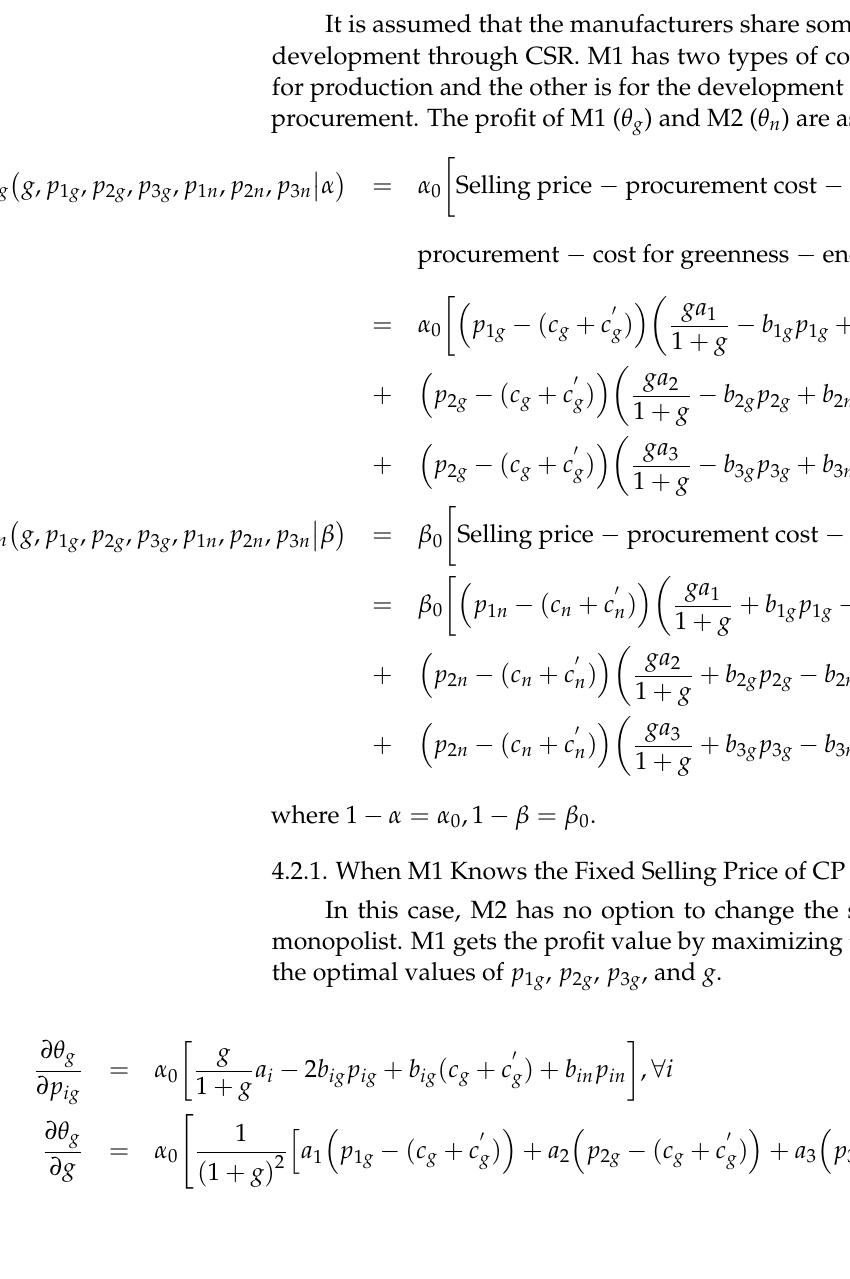
Figure 2. Graphical representation of Model 2 and research